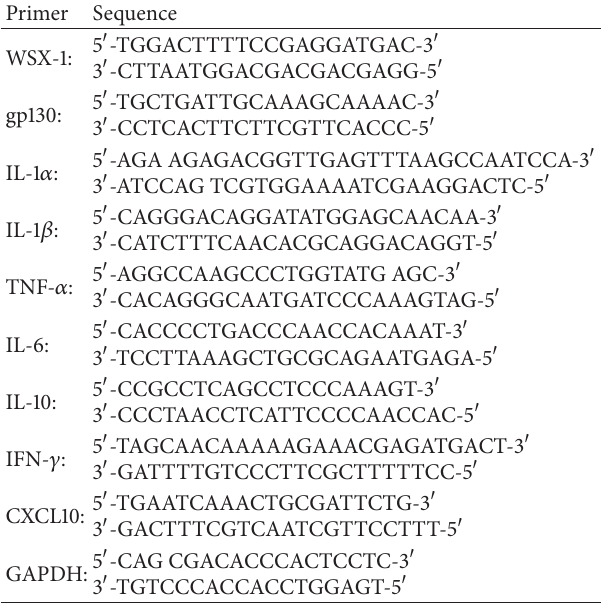
Table 2: Oligonucleotides used for PCR and real-time